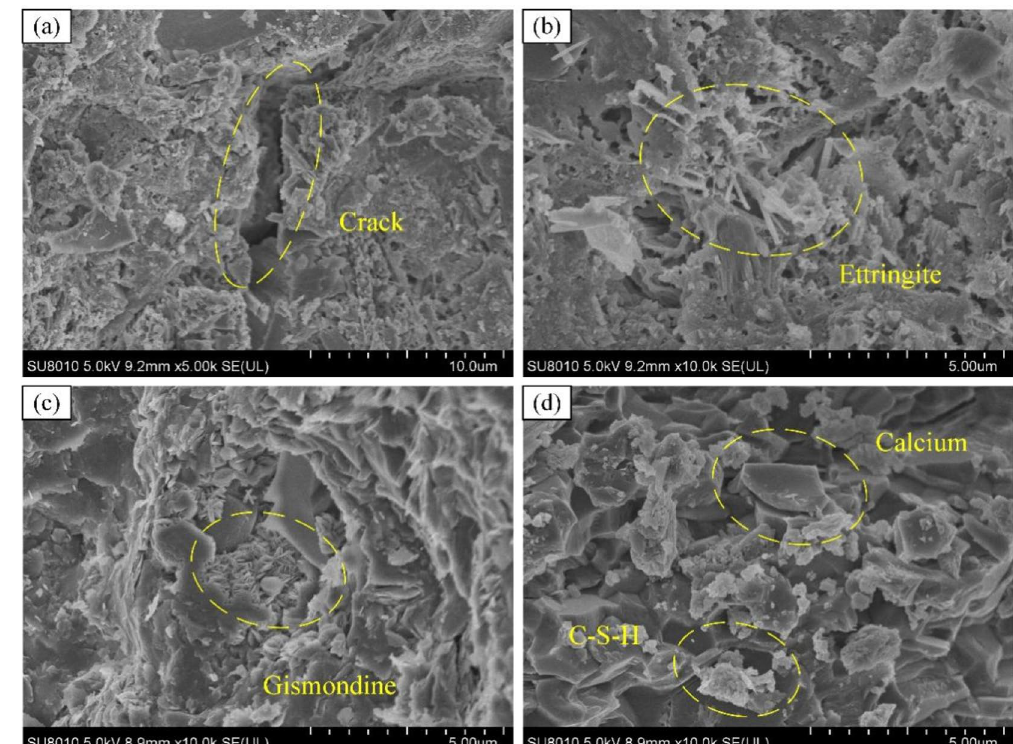
Figure 15. Scanning electron microscopy (SEM) image of desert sand